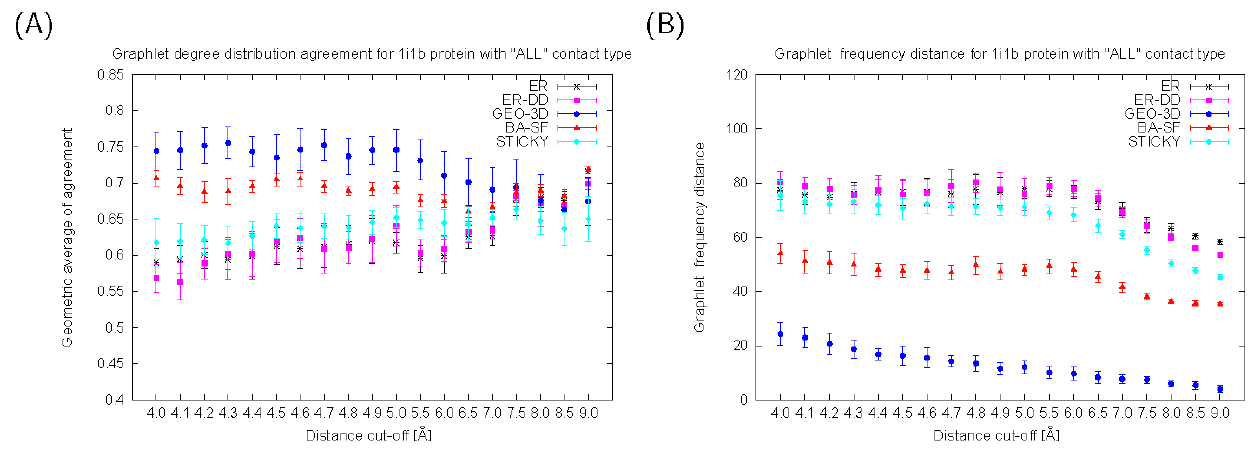
Figure 1. The fit of network models to RIGs corresponding to 1i1b protein. (A) GDD-agreements and (B) RGF-distances between model networks (ER, ER-DD, GEO-3D, SF-BA, and STICKY) and RIGs corresponding to 1i1b protein, that are constructed for ‘‘ALL’’ contact type and a series of distance cut-offs between 4.0 and 9.0 A˚. The larger the GDD-agreement in panel A, the better the fit. The smaller the RGF-distance in panel B, the better the fit.